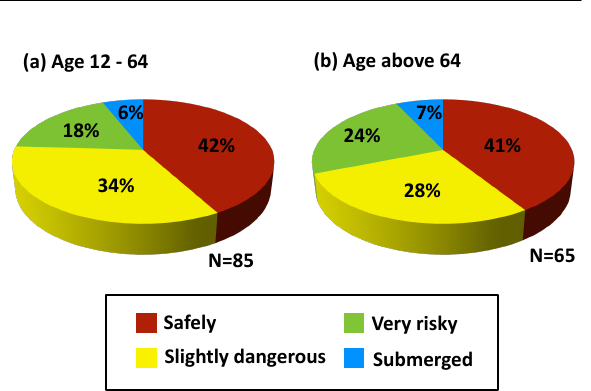
Fig. 5. Replies from the interviewers with the two age groups: 12– 64 (a) and 65 and above (b) in response to the question item No. 6 in Table 2. “N” in each panel shows the number of samples.